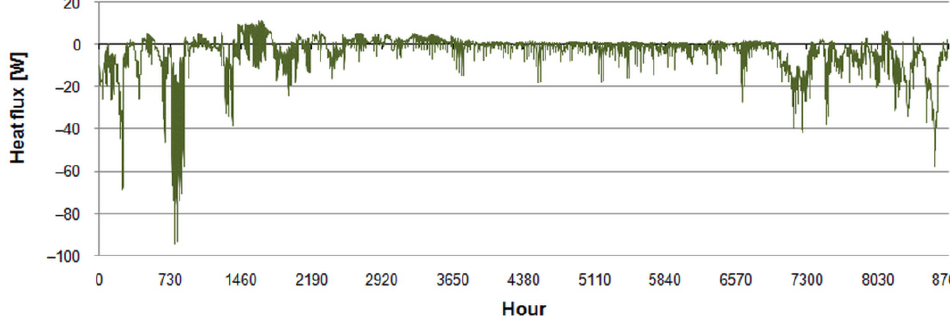
Figure 15. Hourly differences of calculated heat flux from EAHE between methods 5 and 4.